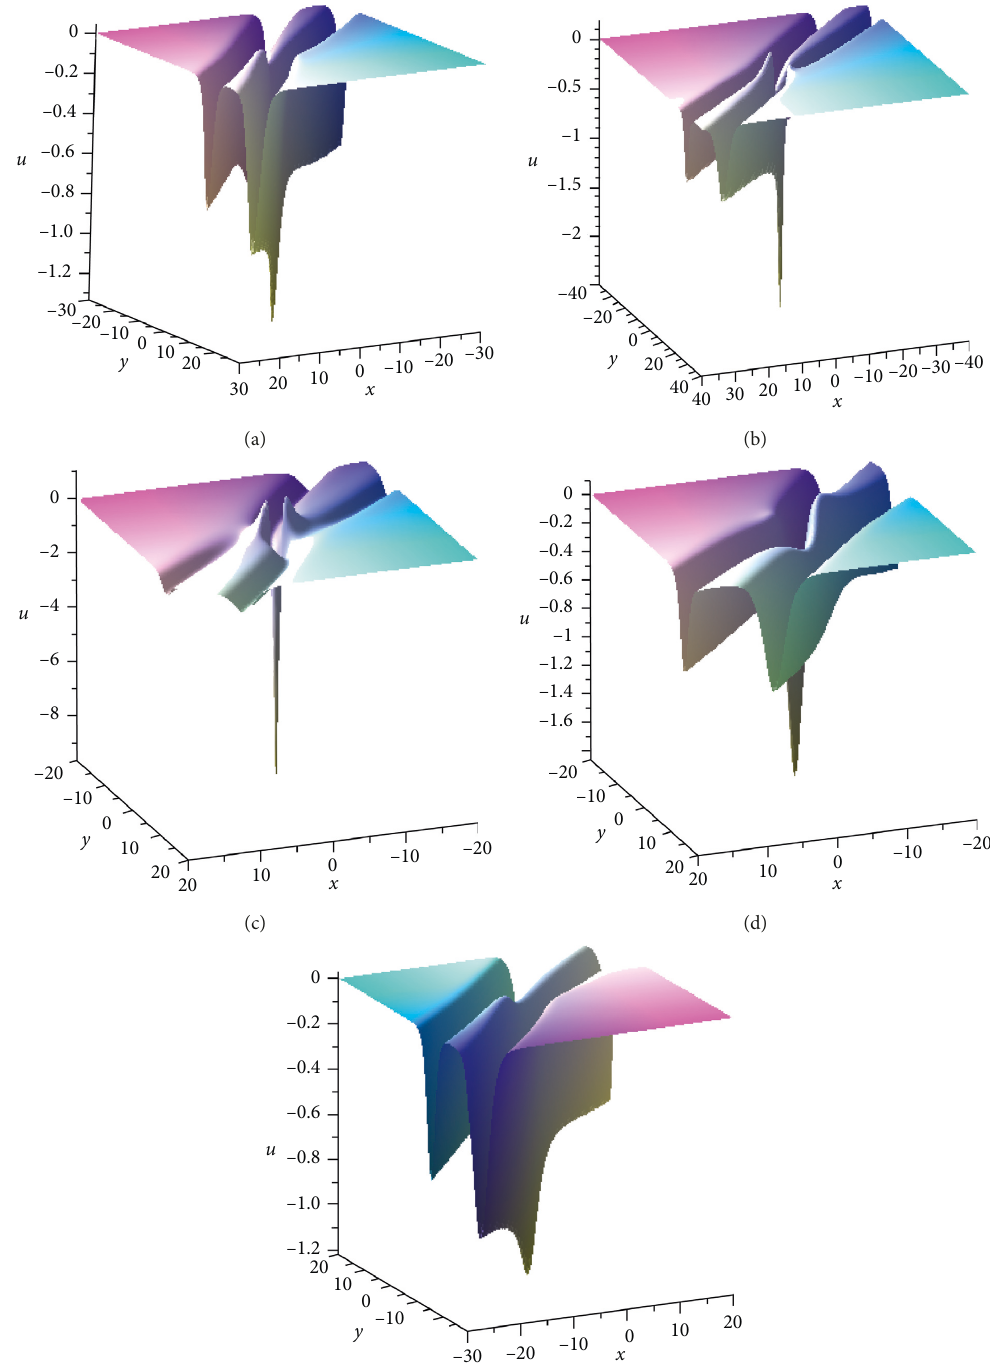
Figure 5: The structure of the interaction solution between lump and stripe solitons (30) with z � 0 and different time t : (a) t � − 6; (b) t � − 3; (c) t � 0; (d) t � 3; (e) t �